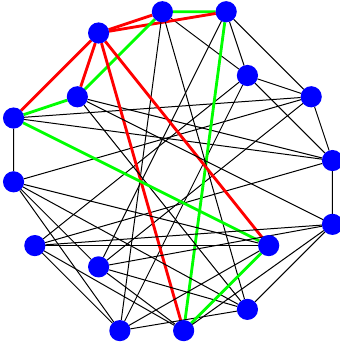
Figure 7. Shrikhande